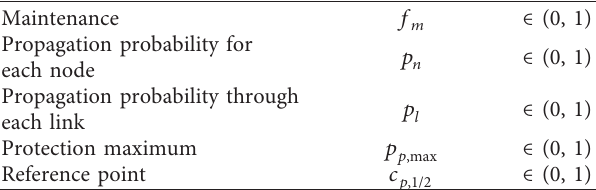
Table 3: Nonevolutionary part (five parameters).